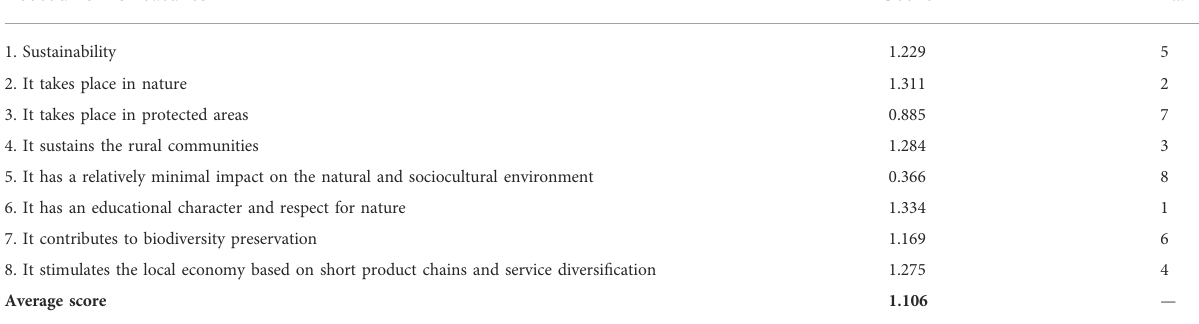
TABLE 3 Scores re fl ecting the young tourist opinion on ecotourism features. Ecotourism ’ s